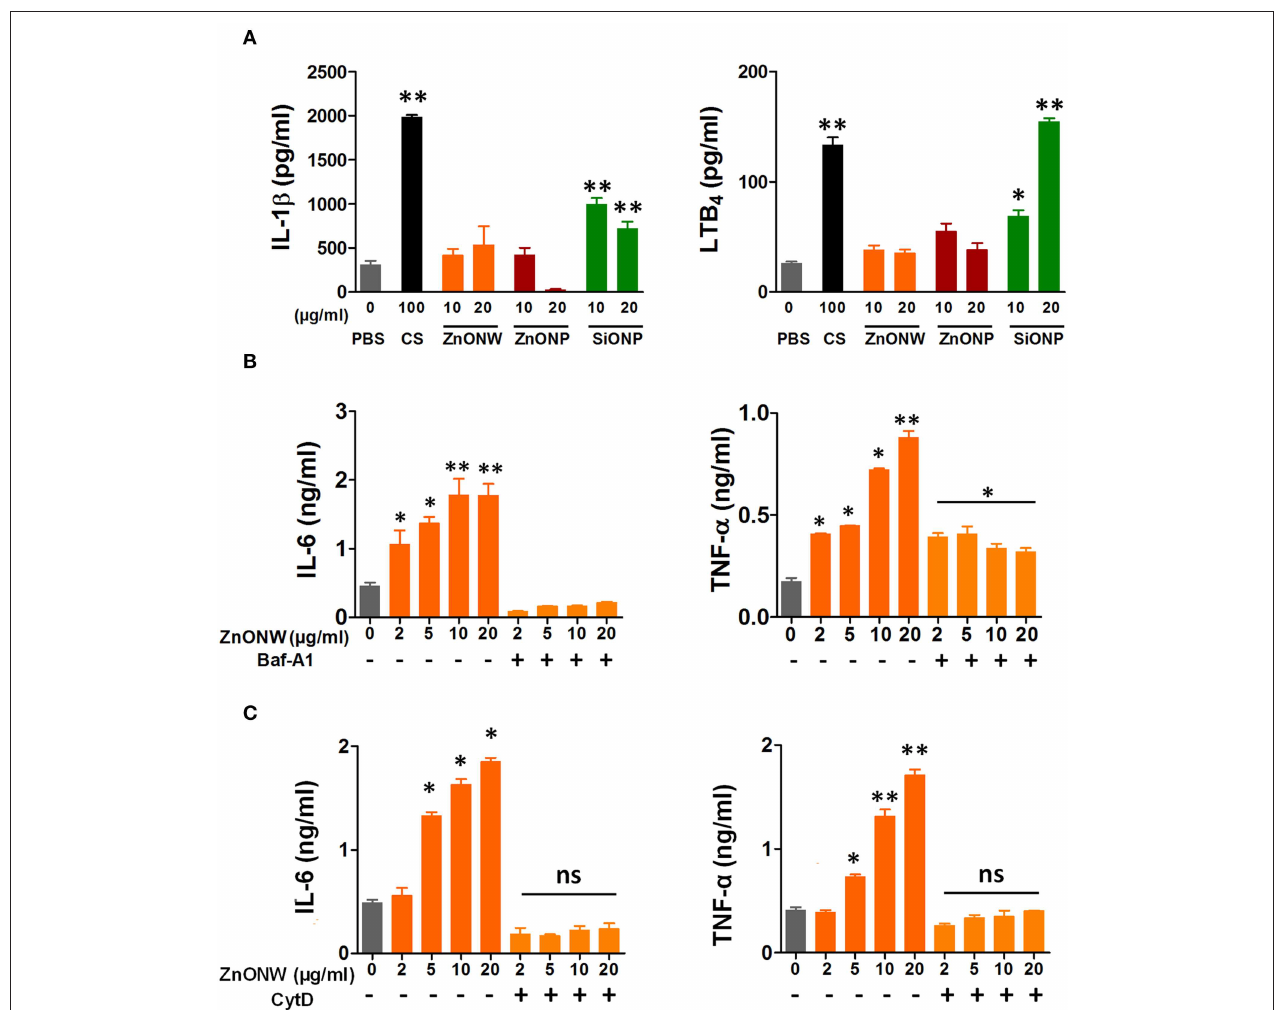
FIGURE 3 | ZnONWs exposure induced release of pro-inflammatory mediators by cultured macrophages. Pro-inflammatory cytokine levels in culture supernatants from cells exposed to PBS or particles (ZnONPs, ZnONWs, and SiONPs) were analyzed using ELISA. IL-1 β and LTB 4 levels were measured in BMDMs exposed for 6h. Cells were primed with LPS (10ng/ml) for 3h and washed and then treated with ZnONWs, ZnONPs, SiONPs, or PBS (A) . BMDMs were treated with LPS (10ng/ml) or PBS for 3h and washed then treated with or without Baf-A1 for 1h. Then cells were treated with ZnONWs or PBS for 6h, IL-6 (LPS-primed), and TNF- α (without LPS priming) levels were measured as indicated (B) . RAW 264.7 cells were stimulated with LPS (10ng/ml) or PBS for 3h and washed then treated with or without CytD (10 µ M) for 1h. Then cells were treated with ZnONWs, ZnONPs, SiONPs, or PBS for 6h, IL-6 (LPS-primed) and TNF- α (without LPS priming) levels were measured as indicated in (C) . Data are representative of three independent experiments in triplicate cultures and values are expressed in ± SEM. * p ≤ 0.05, ** p ≤ 0.01 non-parametric t